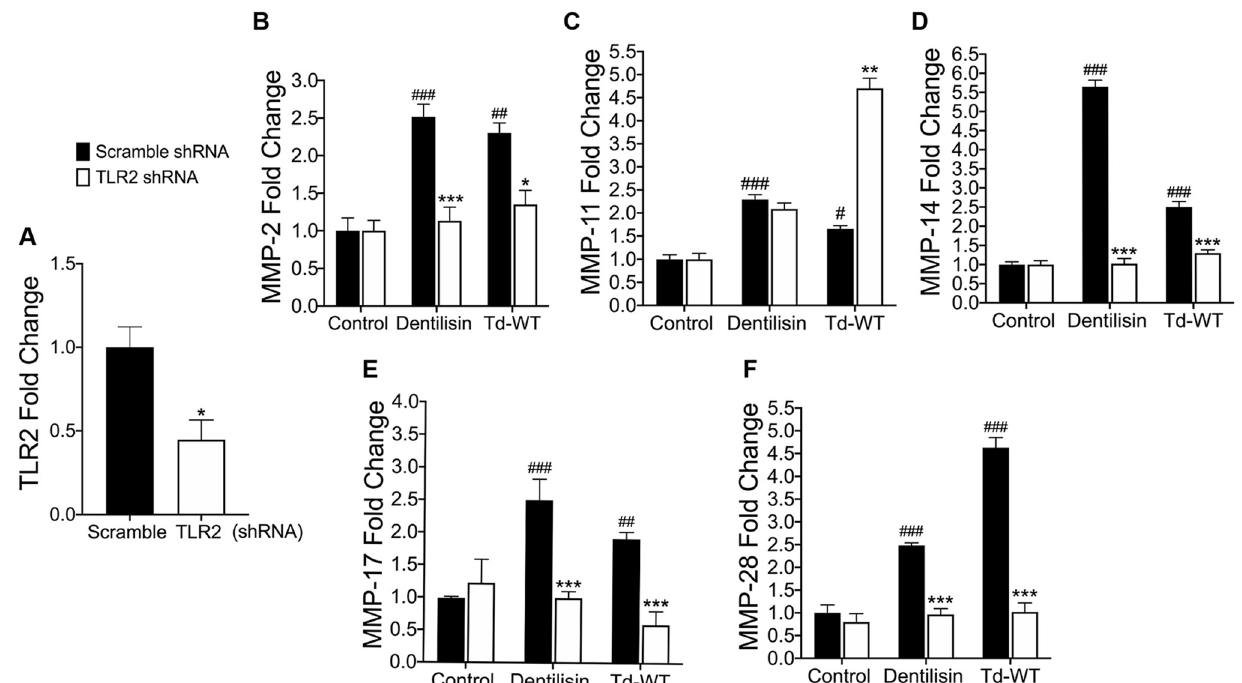
Fig 4. Suppression of TLR2 inhibits T . denticola -stimulated upregulation of MMPs 2 , 14 , 17 and 28 while exacerbating MMP 11 expression in hPDL cells. A) RT-qPCR validation of stable gene suppression using shRNA vectors targeted against TLR2 in healthy hPDL cells. Cells transduced with scrambled shRNA vectors were used as a control. Statistical significance was determined using an unpaired t-test. Bars represent ± SEM of mean value (n = 3 clones). � p < .05 versus control. B-F) RT-qPCR for MMP-2 , MMP-11 , MMP-14 , MMP-17 and MMP-28 mRNA expression of scrambled shRNA control and TLR2 shRNA hPDL cells challenged or stimulated with Td-CF522, purified dentilisin or Td-WT at an MOI of 50 and concentration of 1 μ g/mL for 2-hours in alpha-MEM media with no supplementation followed by a 22-hour incubation in alpha-MEM media supplemented with 10% FBS, 1% Pen/Strep and 1% Amphotericin B. The expression of each gene was normalized to that of GAPDH . Statistical significance was determined using a Two-Way ANOVA followed by post-hoc Tukey’s multiple comparisons. Bars represent mean ± SEM (n = 3). # p < .05 versus scramble control group. ## p < .01 versus scramble control group. ### p < .001 versus scramble control group. � p < .05 versus TLR2 shRNA equivalent group. ��� p < .001 versus TLR2 equivalent shRNA